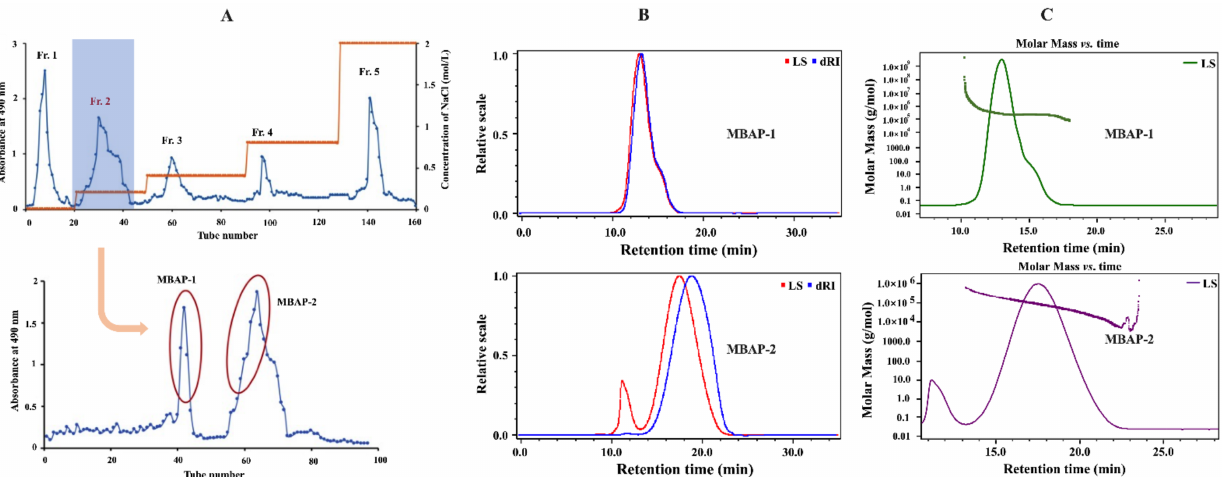
Figure 1. The eluted profiles and HPSEC-MALLS-RI results. ( A ) The eluted profile of MBAP90 on DEAE-52 column and Fr. 2 on Sepharyl S-200 column. ( B ) Superimposed spectra detected us- ing RI and LC at angle of 90 ◦ on HPSEC-MALLS-RI. ( C ) Molar mass distribution detected by